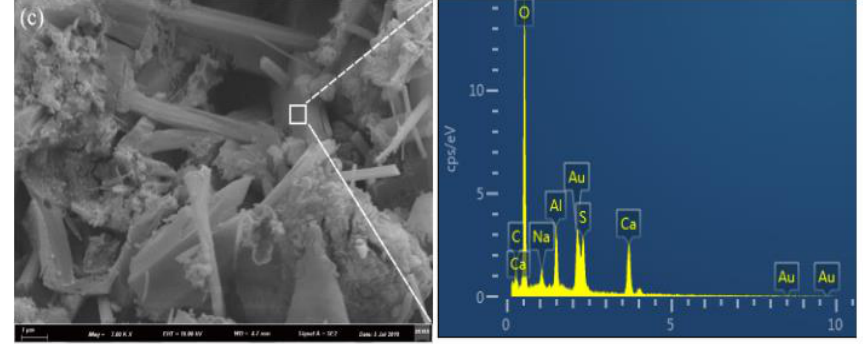
Figure 5. SEM images of samples hydrated for 28 days: ( a ) −15 °C ; ( b ) 0 °C; and ( c ) 20 ° C .